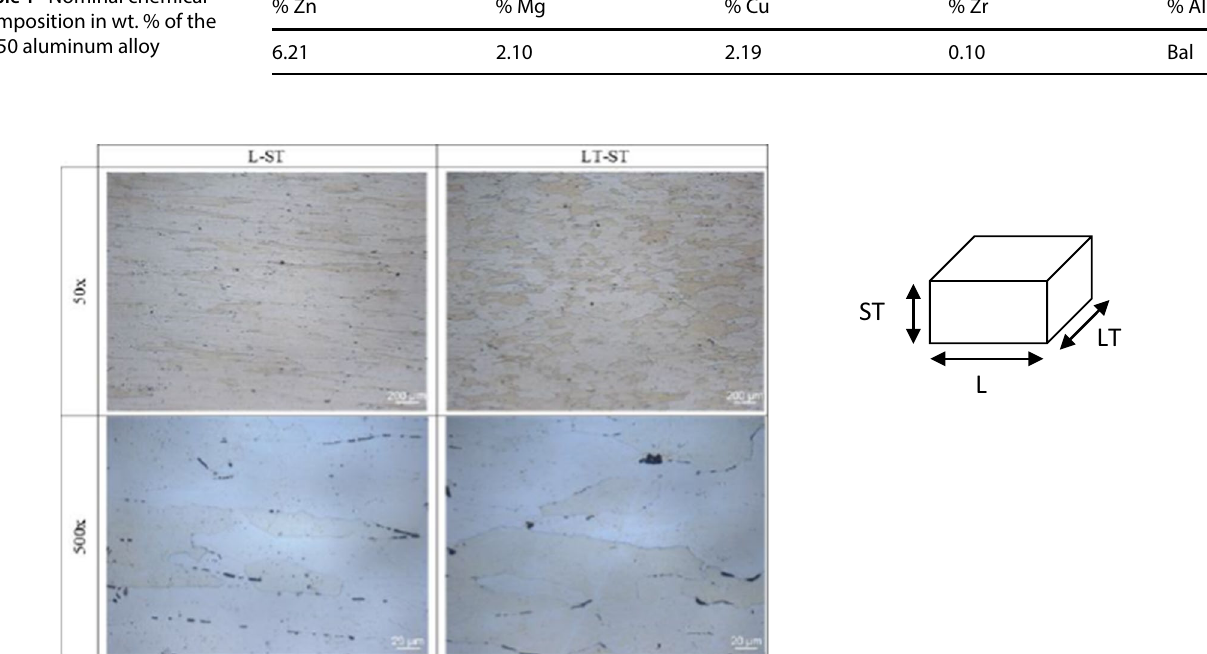
Table 1 Nominal chemical composition in wt. % of the 7050 aluminum alloy